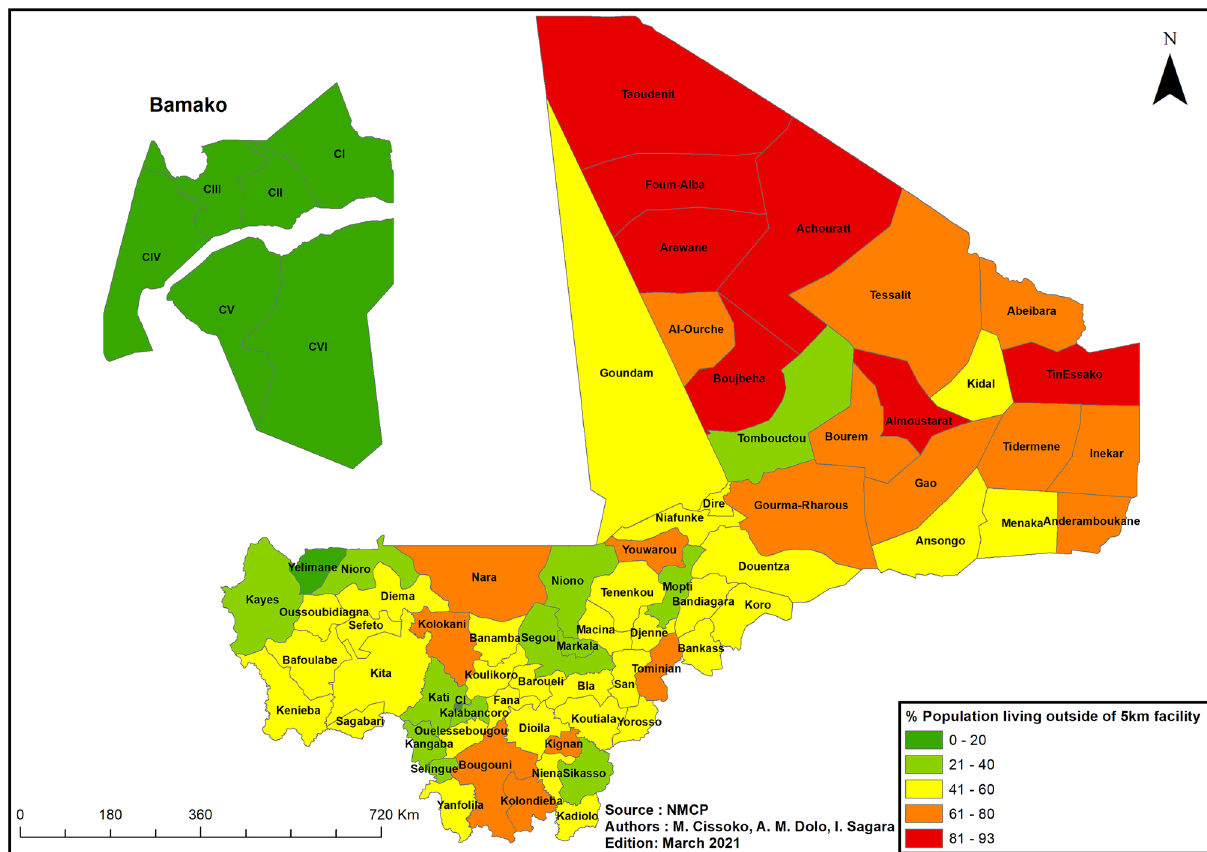
Figure 7. Percentage of the population living outside a radius of 5 km from a health facility access, Mali, 2019. ArcGIS Desktop version 10.8 software (Environmental Systems Research Institute (ESRI), 380 New York Street, Redlands, CA 92373-8100, USA, https:// www. esri.